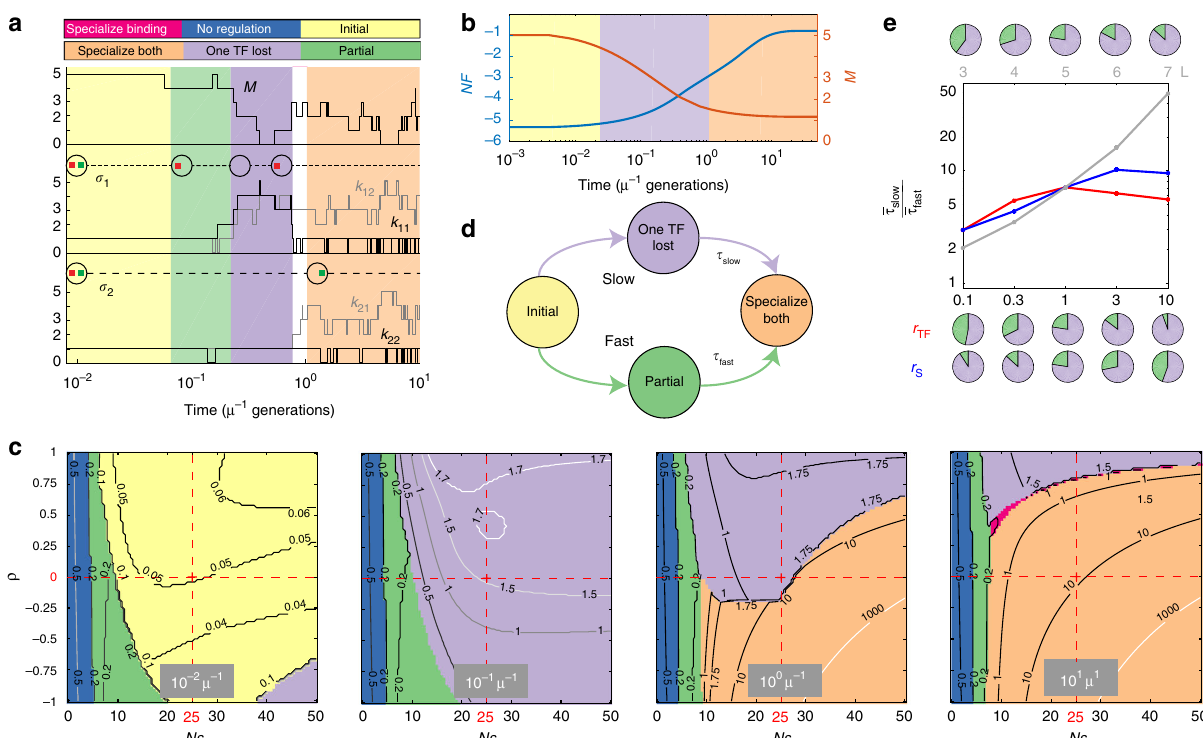
Fig. 4 Slow and fast pathways to TF specialization. a Temporal traces of TF – TF match M ( top ), and TF – BS mismatches k ij ( middle : TF1, bottom : TF2) with the corresponding signal speci fi city mutations denoted on dashed lines , for one example evolutionary trajectory at baseline parameters. Macrostates are color- coded as in the top legend and Fig. 3. b Average dynamics of fi tness NF ( blue , left scale ) and TF – TF match M ( red , right scale ). For every timepoint, the dominant macrostate is denoted in color. c Snapshots of dominant macrostates (at increasing time post-duplication as indicated in the panels), shown for different combinations of selection strength Ns and signal correlation ρ as in Fig. 3. Contours mark dwell times in the dominant macrostates (in units of μ − 1 ). Red cross = baseline parameters. d Schematic of the two alternative pathways to specialization. τ τ slow and fast are the total times to specialization for the ‘ slow ’ and the ‘ fast ’ pathway, respectively. e Relative duration of the two pathways, as a function of binding site length L ( gray line , top axis ), TF consensus sequence mutation rate r TF ( red ), and signal domain mutation rate r S (blue, bottom axis ). Pie charts indicate the fraction of slow ( pink ) and fast ( green ) pathways at each parameter